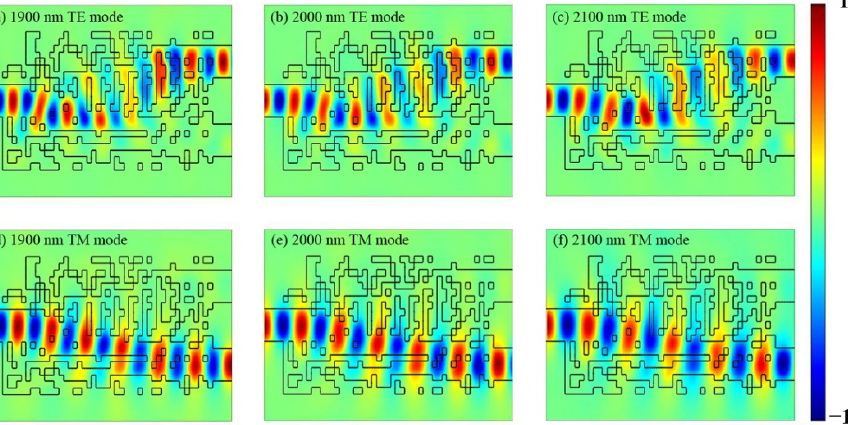
Figure 4. ( a – c ) and ( d – f ) are H z field distributions of TE modes and E z field distributions of the TM modes for the digital-topology structure, respectively.